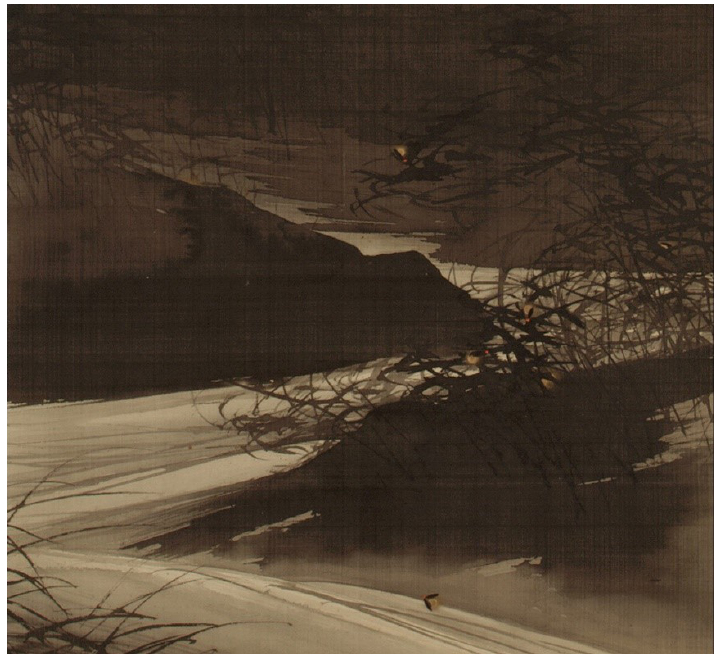
Figure 2. (T127). Fireflies Over the Uji River by Moonlight (detail). Meiji period (1868–1912). Suzuki Shōnen (Japanese, 1849 –1918). Painting, hanging scroll; ink, color, and gold on silk. Purchase, Gift of Mrs. Russell Sage, by exchange, 1979. Accession Number: 1979.72. The Metropolian Museum of Art, New York, USA, www.metmuseum.org (accessed 4 January 2022). Open access image, CC0. Artists used different strategies to convey nocturnal or twilight settings. Some prints had a solid black background (e.g., Chōki T16, Figure 3a), a grayish (e.g., T10, T73-74, T79, T129, T157) or blue sky (e.g., Kunichika T67, Figure 3b). Many images had a lighter back- ground with a dark streak at the top (e.g., T20, T44, T78, T90, T92, T112), and one had an orange horizon akin to a sunset (T141). However, many images of people watching or collecting fireflies had a light background without any indication of darkness (e.g., T42, T140, T144-146, T158), some of which were benizuri-e style prints (T54, T182).